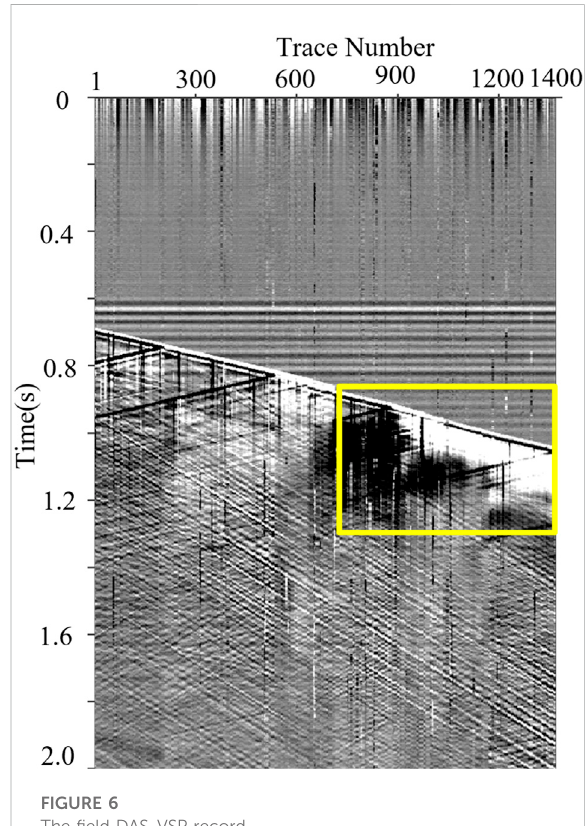
FIGURE 6 The fi eld DAS-VSP